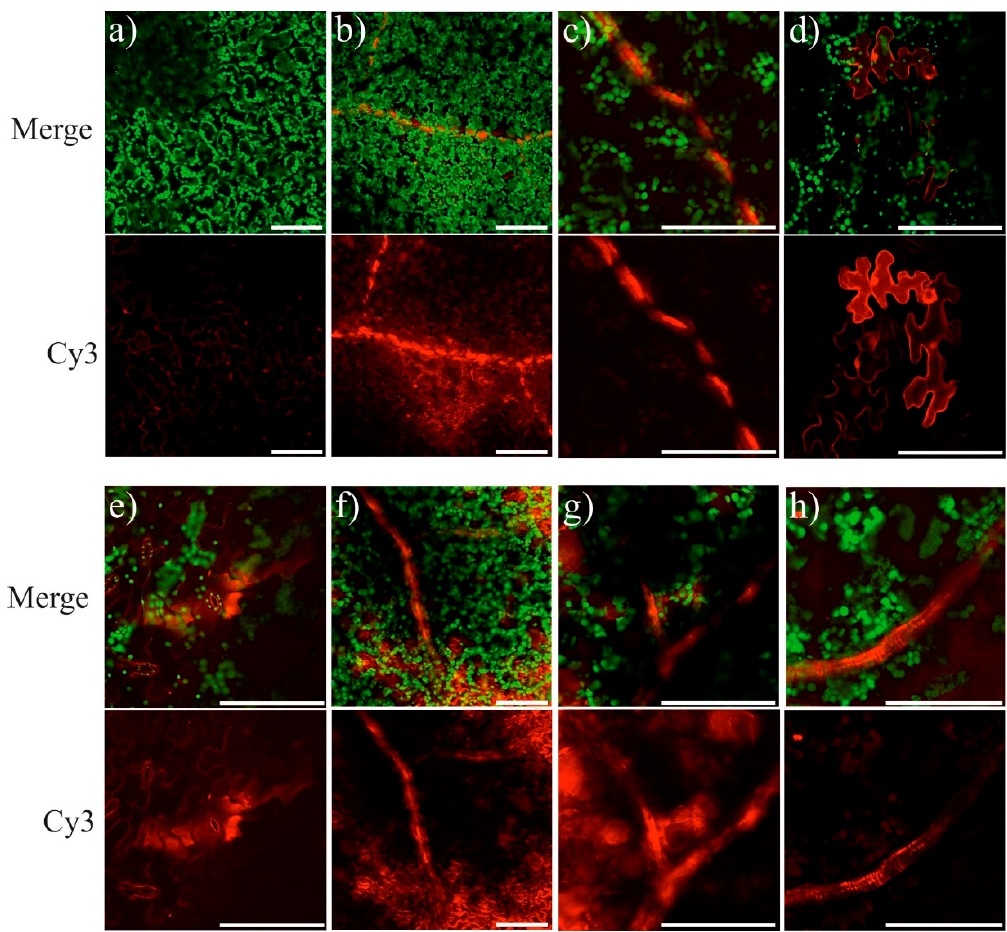
Figure 7. Detection of Cy3-labeled AtCHS-dsRNA (red) in the externally treated Arabidopsis thaliana leaves by laser scanning microscopy. Adaxial ( a – c ) and abaxial ( d – h ) leaf sides of four-week old A. thaliana were exogenously treated with the labeled AtCHS -dsRNA (red) by sterile soft brushes and analyzed 13–15 h post-treatment. ( a ) Negative control (sterile water); ( b – h )— AtCHS -dsRNA treatment. Green color results from the autofluorescence of chloroplasts. Red color results from the Cy3-labeled dsRNA. Scale bars, 100 µm. Three independent trials showed the same results.